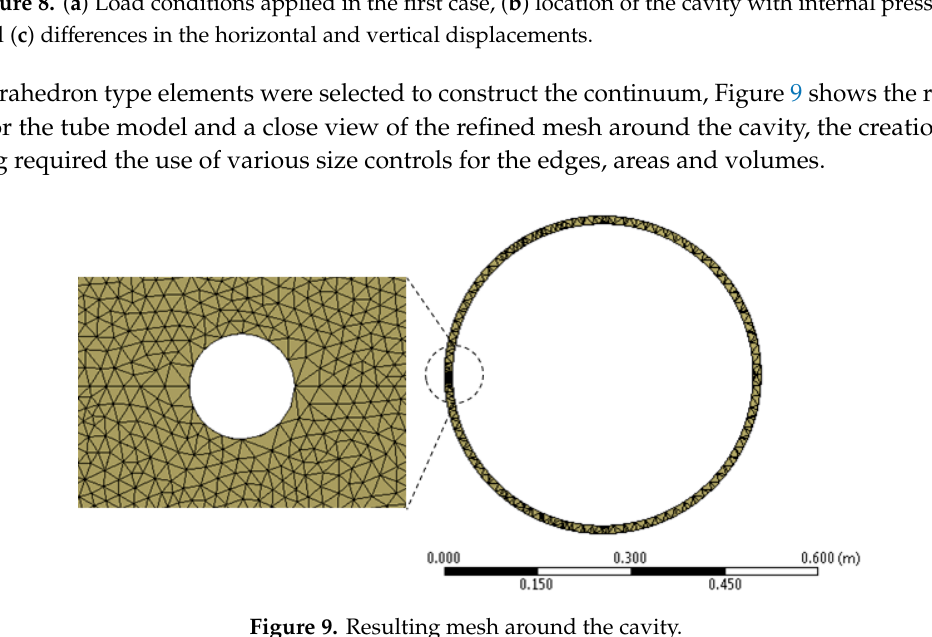
Figure 9. Resulting mesh around the cavity.